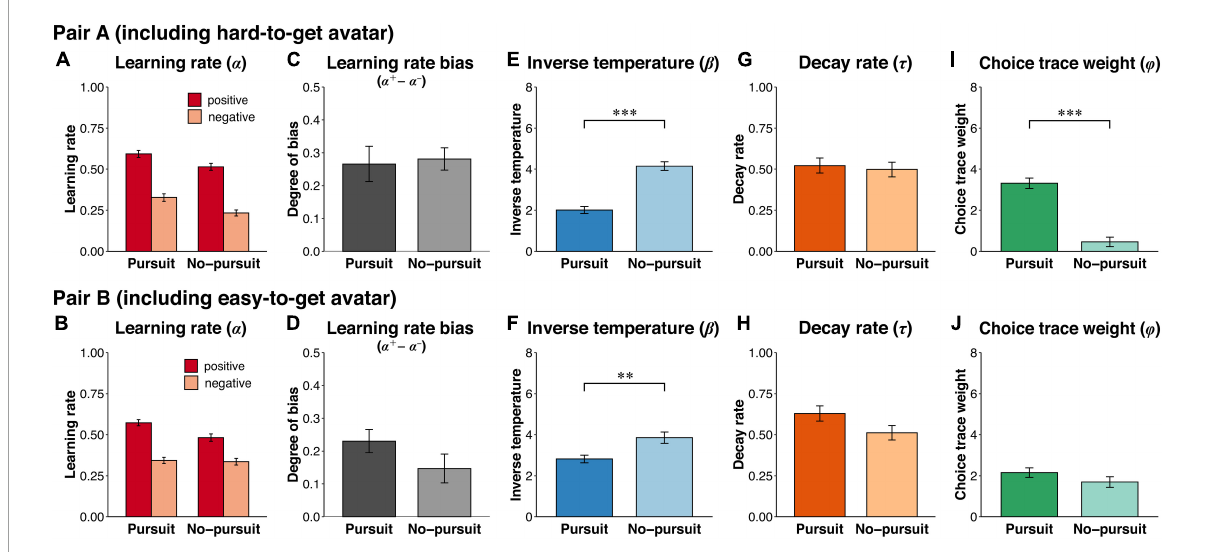
FIGURE6 Estimated parameters with the hybrid model in each pair. The figure shows estimated parameters by fitting the hybrid model to the choice datasets separated by avatar pair. Upper and lower rows indicate estimated parameters for pair A (including the hard-to-get avatar) and pair B (including the easy-to-get avatar), respectively. (A,B) The learning rates for the positive and negative reward prediction errors ( α + and α − ). (C,D) The learning rate bias calculated by subtracting the negative learning rate from the positive learning rate ( α + − α − ), indicating the degree of asymmetric value updating. (E,F) The inverse temperature ( β ) representing the sensitivity to value differences in decision-making. (G,H) The decay rate ( τ ) indicating how far past choices are incorporated into the next choice. (I,J) The weight of choice history ( ϕ ) representing the sensitivity to differences in the choice history in decision-making. Error bars represent the standard error of the mean. Asterisks denote significant group differences: ∗∗∗ p < 0.001 and ∗∗ p <